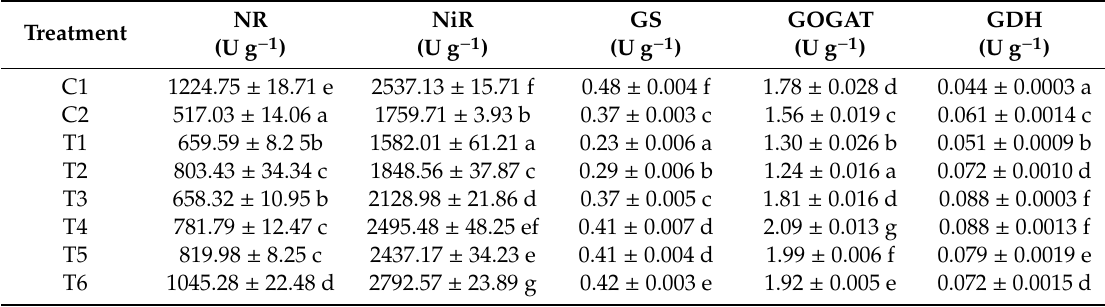
Table 3. E ff ects of IAA on N Metabolizing Enzymes Activities under Copper Stress.